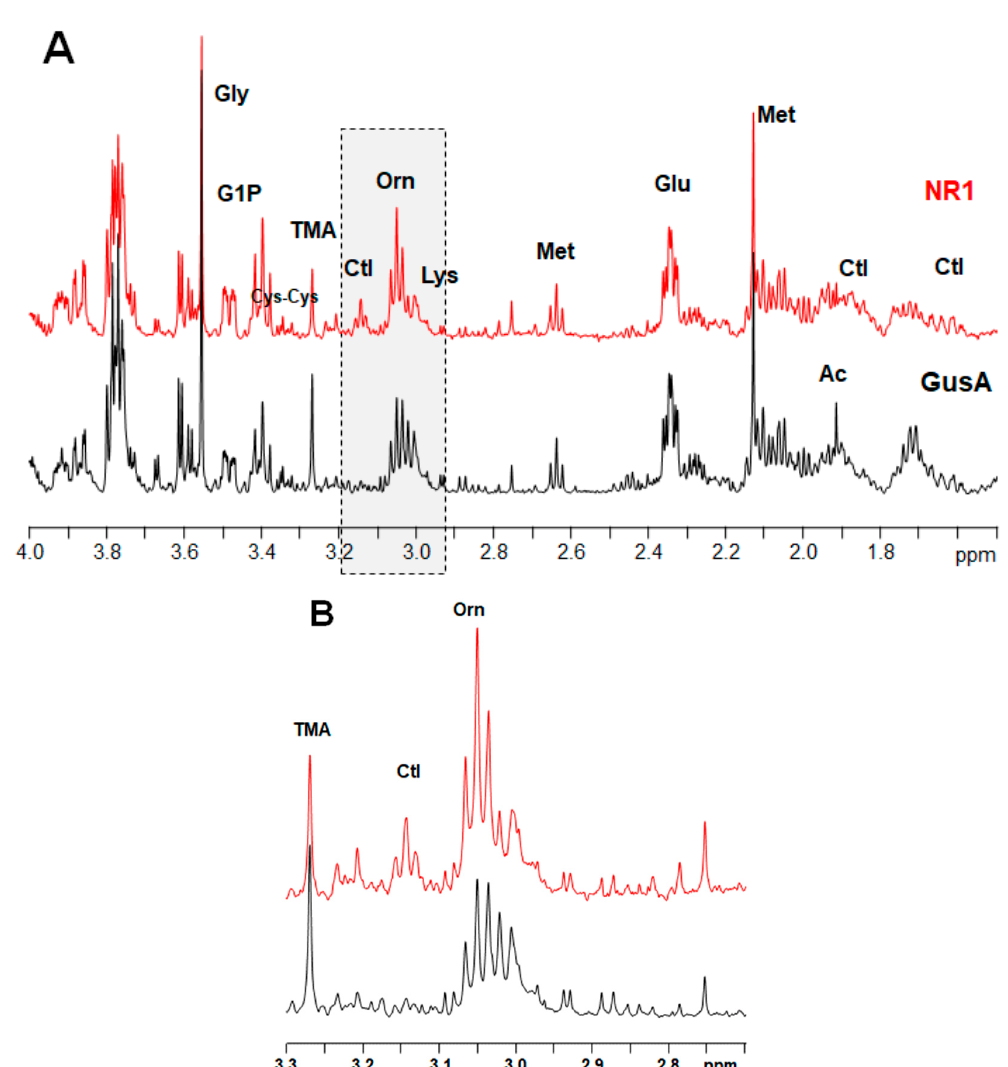
Figure 4. Representative 1 H HR-MAS NMR spectra of suspensions of NR1 and GusA trophozoites in phosphate bu ff ered saline (PBS). The resonances of citrulline (Ctl) and Ornithine (Orn) between 3.0 and 3.2 ppm are highlighted by the gray box. ( A ) Spectral region from 1.5 ppm to 4 ppm, ( B ) highlighted region in detail.